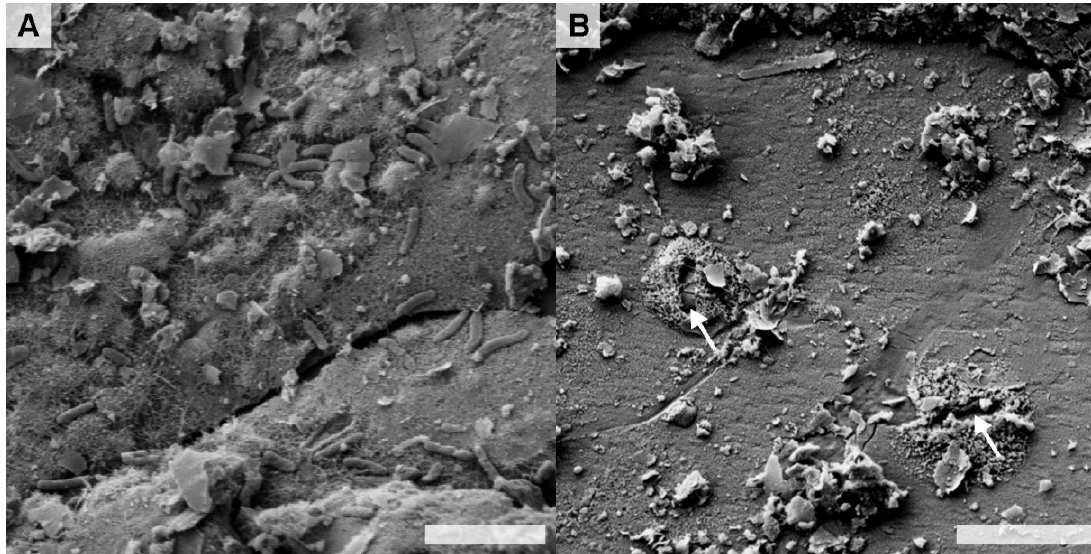
Figure 3. Field emission-scanning electron microscopy secondary electron (FE-SEM SE) micrographs of: ( A ) bacterially-colonized secondary Fe(III) (oxy)hydroxysulfate precipitates at the sulfide-mineral surface in FC-2-3A (EDS analysis indicated the presence of Fe, S and O—data not shown); and ( B ) relic direct attachment pits at the surface of a chalcophyrite grain in Pile 2. Scale bars equal 3